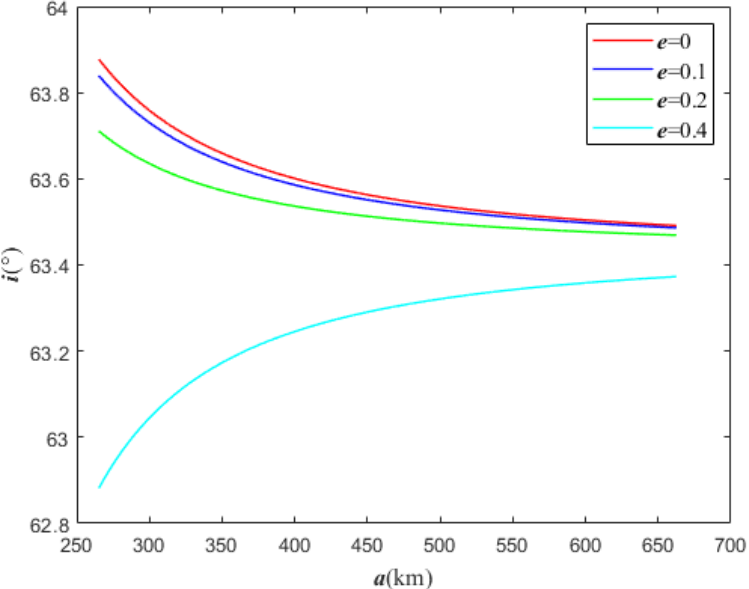
Figure 6. Variation of the critical inclination I as a function of the semi-major axis a with respect to different values of eccentricity e .